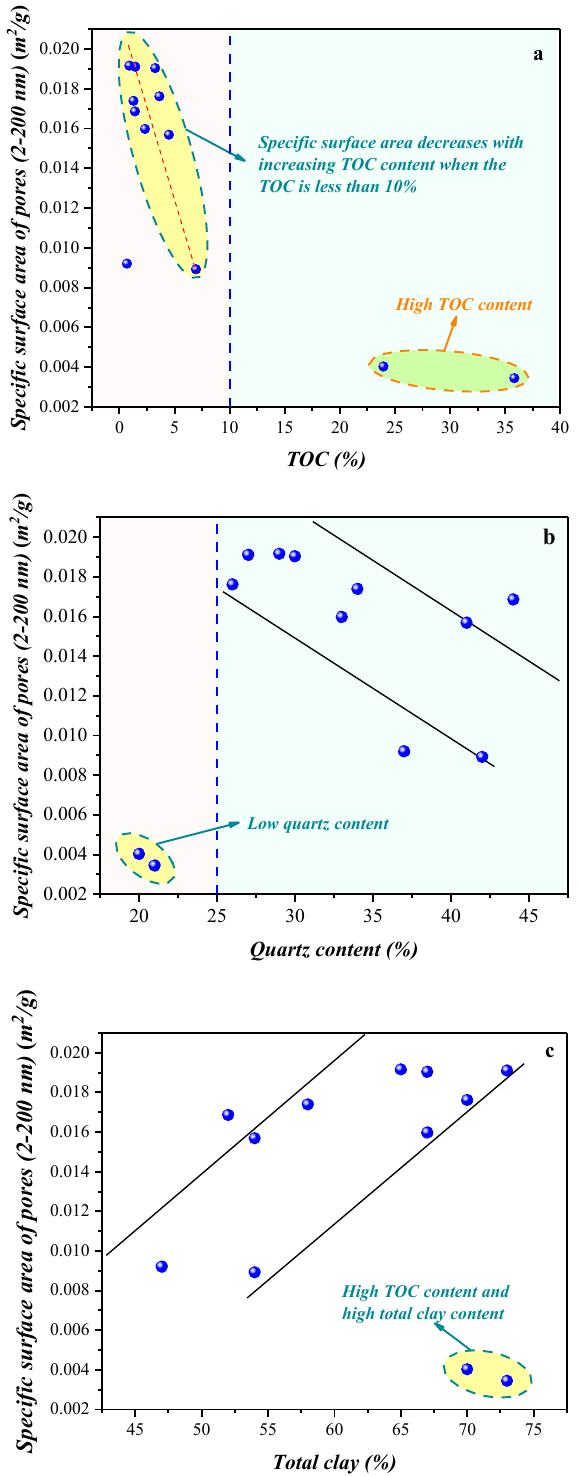
Figure 11. ( a ) Relationship between specific surface area of pores (2–200 nm) by the low-temperature N 2 adsorption experiment and TOC content; ( b ) relationship between specific surface area of pores (2–200 nm) by the low-temperature N 2 adsorption experiment and quartz content; and ( c ) relationship between specific surface area of pores (2–200 nm) by the low-temperature N 2 adsorption experiment and total clay content.